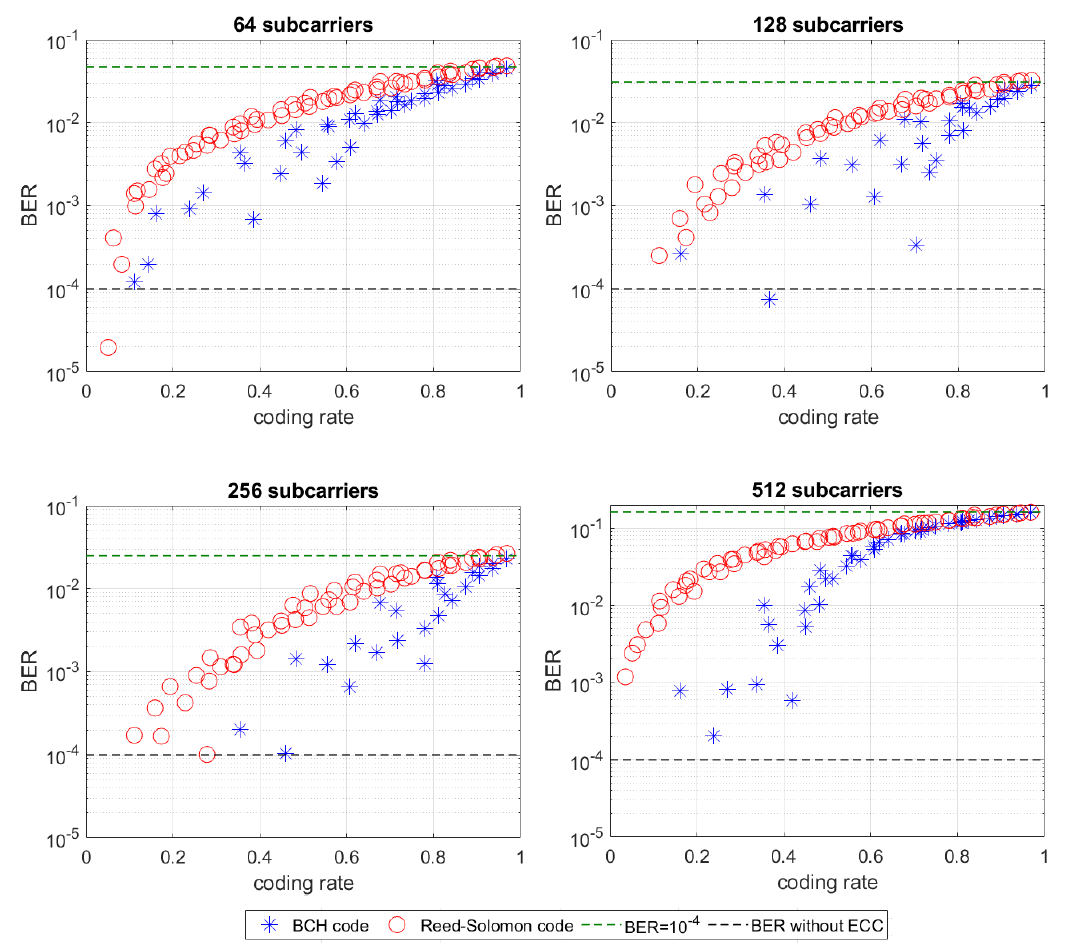
Figure 7. BER of OFDM data transmission as a function of ECC rate: BCH (*) and Reed–Solomon (o); black line indicates BER equal to 10 − 4 ; green line indicates BER of transmission without ECC. Table 3. Coding rates and data transmission rates during transmission with